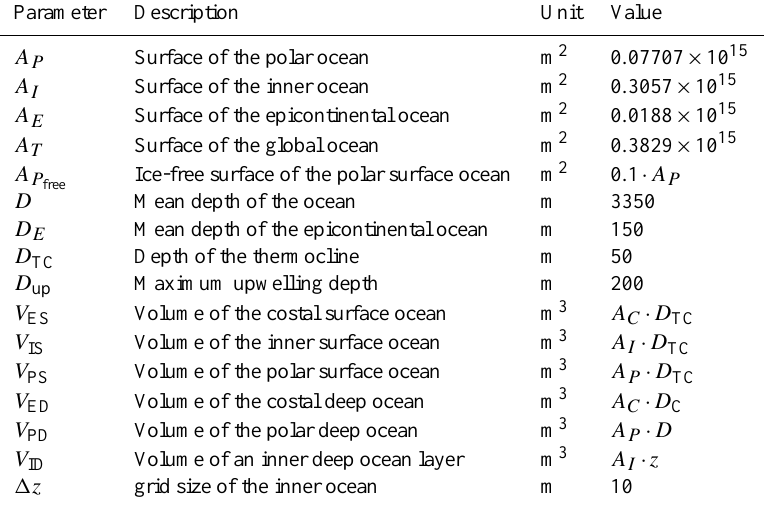
Table 3. Physical set-up of the ocean circulation model.